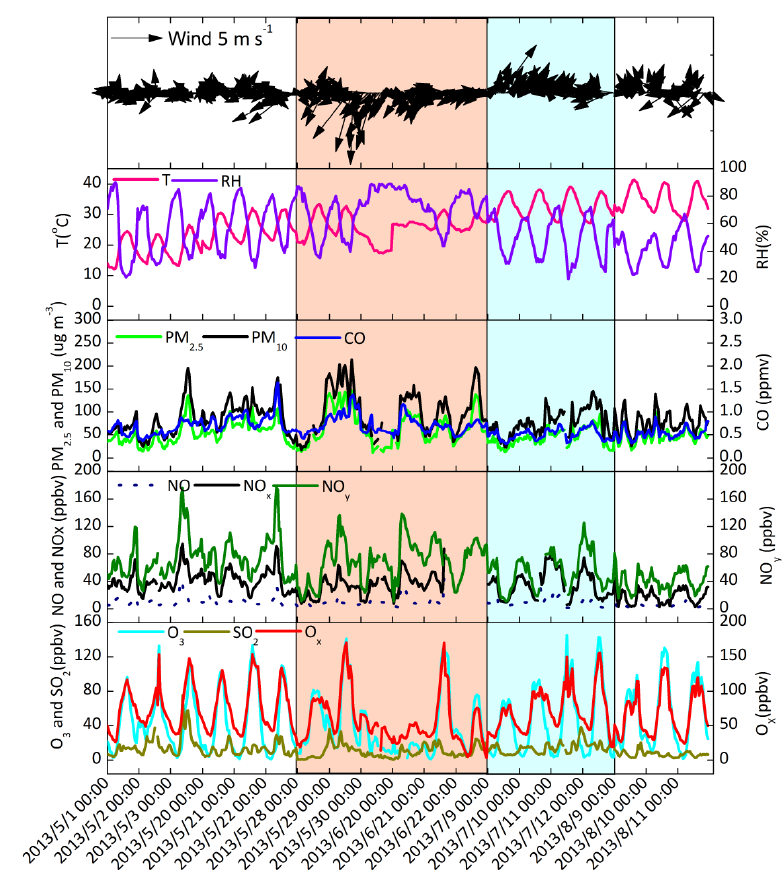
Figure 10. Same as Fig. 8 but during the photochemical pollution period. The orange shaded area represents Phase I (28–30 May and 20– 22 June), the cyan shaded area indicates Phase II (9–12 July), and the other area represents Phase III (1–3 May, 20–22 May, and 9–11